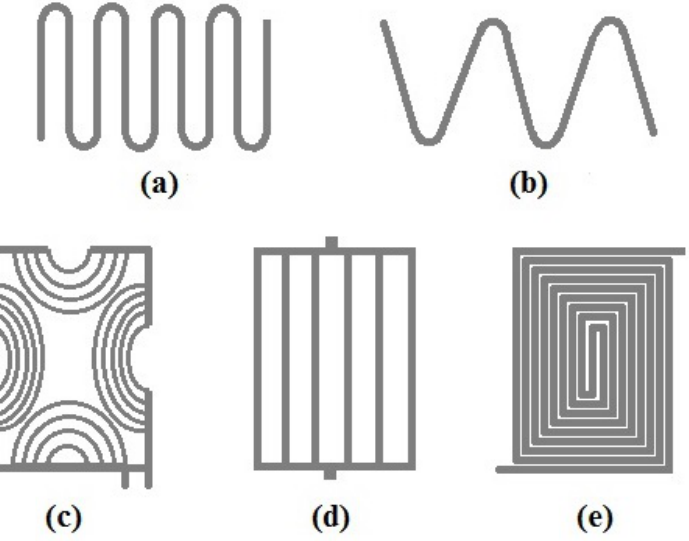
Figure 2. Flow passages of a liqid-based PV/T collector: ( a ) oscillatory flow, ( b ) serpentine flow, ( c ) web flow, ( d ) parallel flow and ( e ) parallel-serpentine